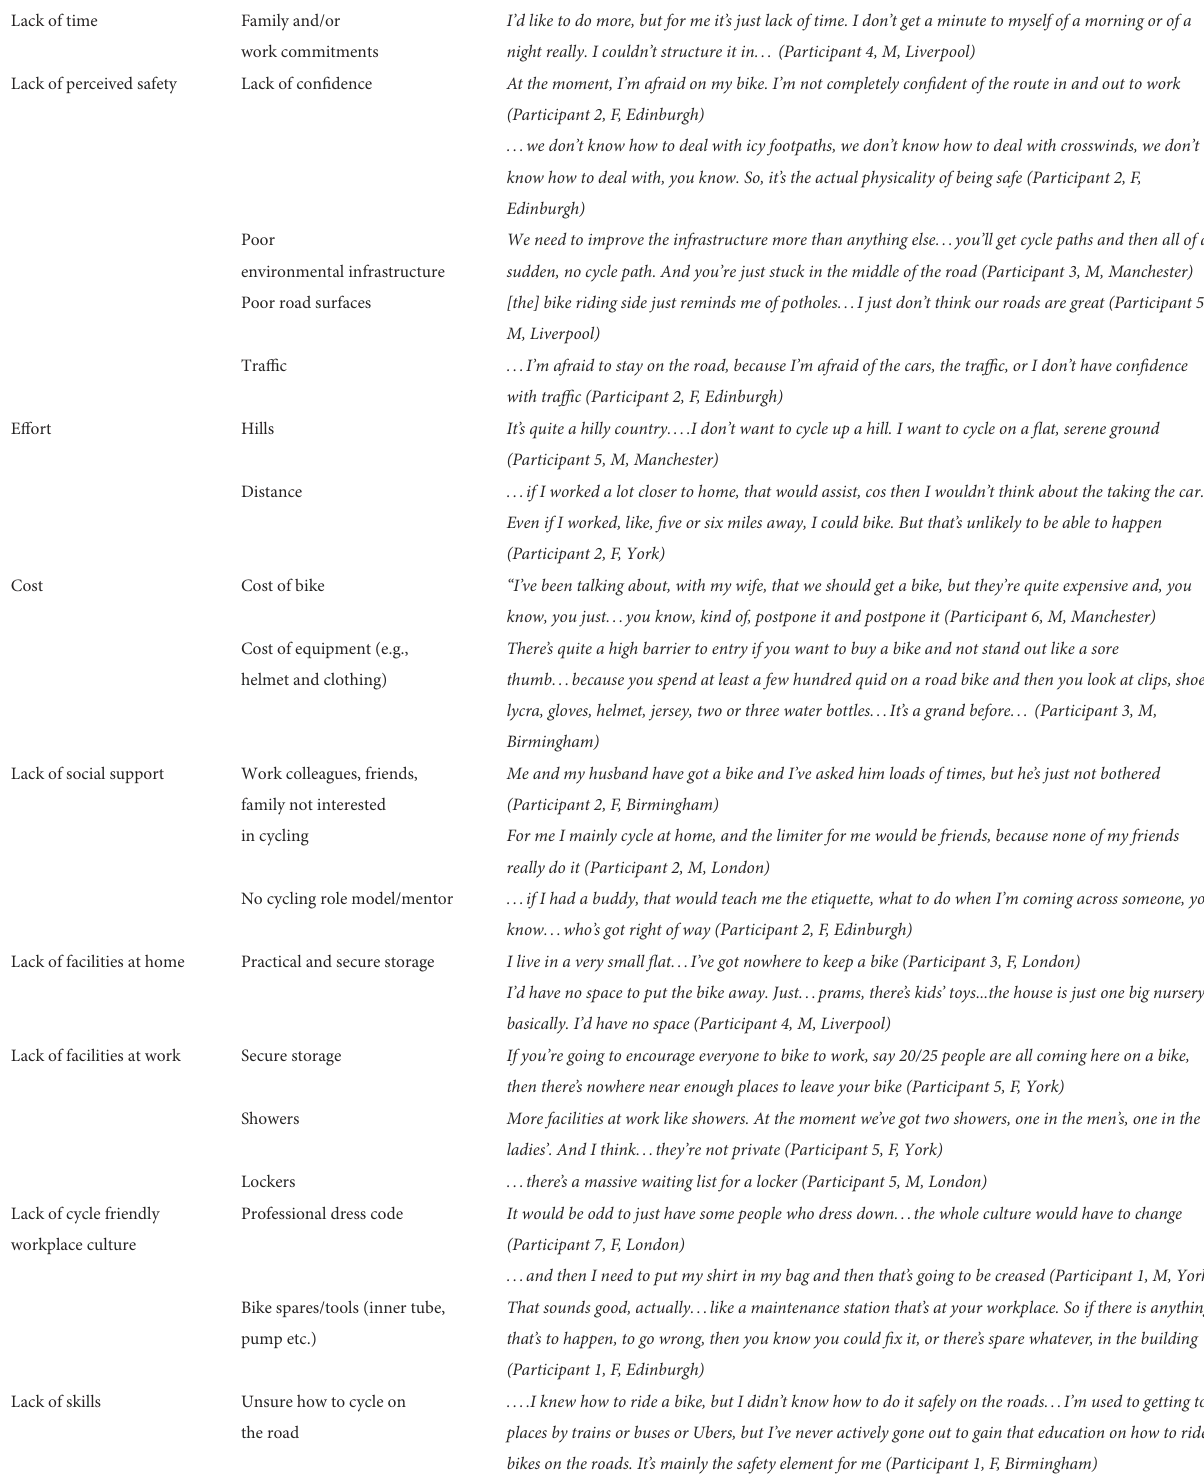
TABLE 3 Broad barriers and specific factors limiting cycling identified by HSBC UK staff focus group participants. Broad